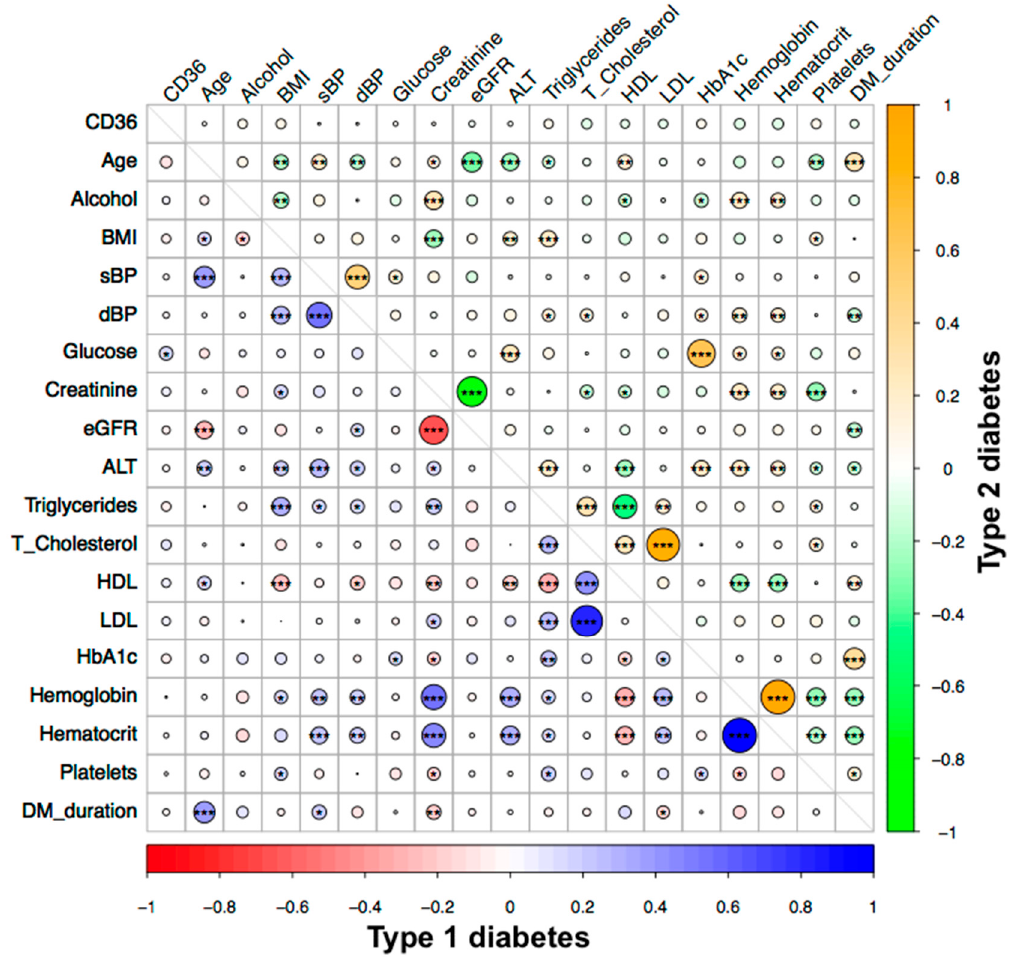
Figure 1. Correlation analysis of circulating sCD36 and clinical variables in type 1 diabetes (T1D) (red–blue) and type 2 diabetes (T2D) (green–orange) groups. Spearman’s correlation is significant at the 0.05 *, 0.01 **, and 0.001 *** levels (2-tailed). BMI, Body mass index; sBP, systolic blood pressure; dBP, diastolic blood pressure; eGFR, estimated glomerular filtration rate (MDRD4_IDMS equation); ALT, alanine aminotransferase; HDL, high-density lipoprotein; LDL, low-density lipoprotein; HbA1c, glycated haemoglobin; DM duration, diabetes duration.